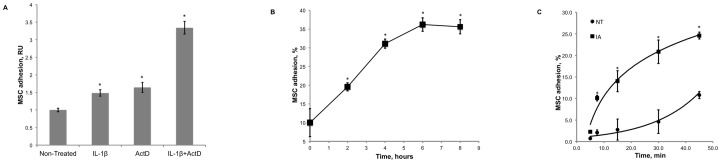
MSC adhesion to HUVECs.HUVECs were treated at 37°C and 5% CO2 with 10 ng/ml IL-1ß, 10 µg/ml actinomycin D (ActD) or 10 ng/ml IL-1ß in the presence of 10 µg/ml actinomycin D for 0–8 hours in supplemented EGM-2 medium. Panel A shows MSC adhesion to HUVECs treated with IL-1ß, actinomycin D or IL-1ß in the presence of actinomycin D for 4 hours. IL-1ß stimulated the MSC adhesion 1.5-fold. Actinomycin D stimulated the MSC adhesion 1.6-fold. A mixture of IL-1ß and actinomycin D stimulated the MSC adhesion 3.5-fold. Data shown are the averages and standard deviations of five adhesion assays. Asterisks mark statistically significant changes (p-value <0.05) in the MSC adhesion in comparison with the adhesion to untreated HUVECs. Panel B shows the changes in HUVEC adhesiveness for MSCs during the treatment with IL-1ß in the presence of actinomycin D for 0, 2, 4, 6 and 8 hours. Data shown are the average percentages of adherent MSCs (n = 4) after 10 minutes of incubation with HUVECs. Error bars represent standard deviations. Asterisks mark statistically significant changes (p-value <0.05) in the MSC adhesion in comparison with the adhesion to untreated HUVECs. Panel C shows the time courses of MSC adhesion to untreated HUVECs (NT) and to HUVECs treated with IL-1ß in the presence of actinomycin D (IA) for 4 hours. Data shown are the averages and standard deviations of four adhesion assays. Asterisks mark the time points when the MSC adhesion was statistically different (p-value <0.05) from MSC adhesion to untreated HUVECs.